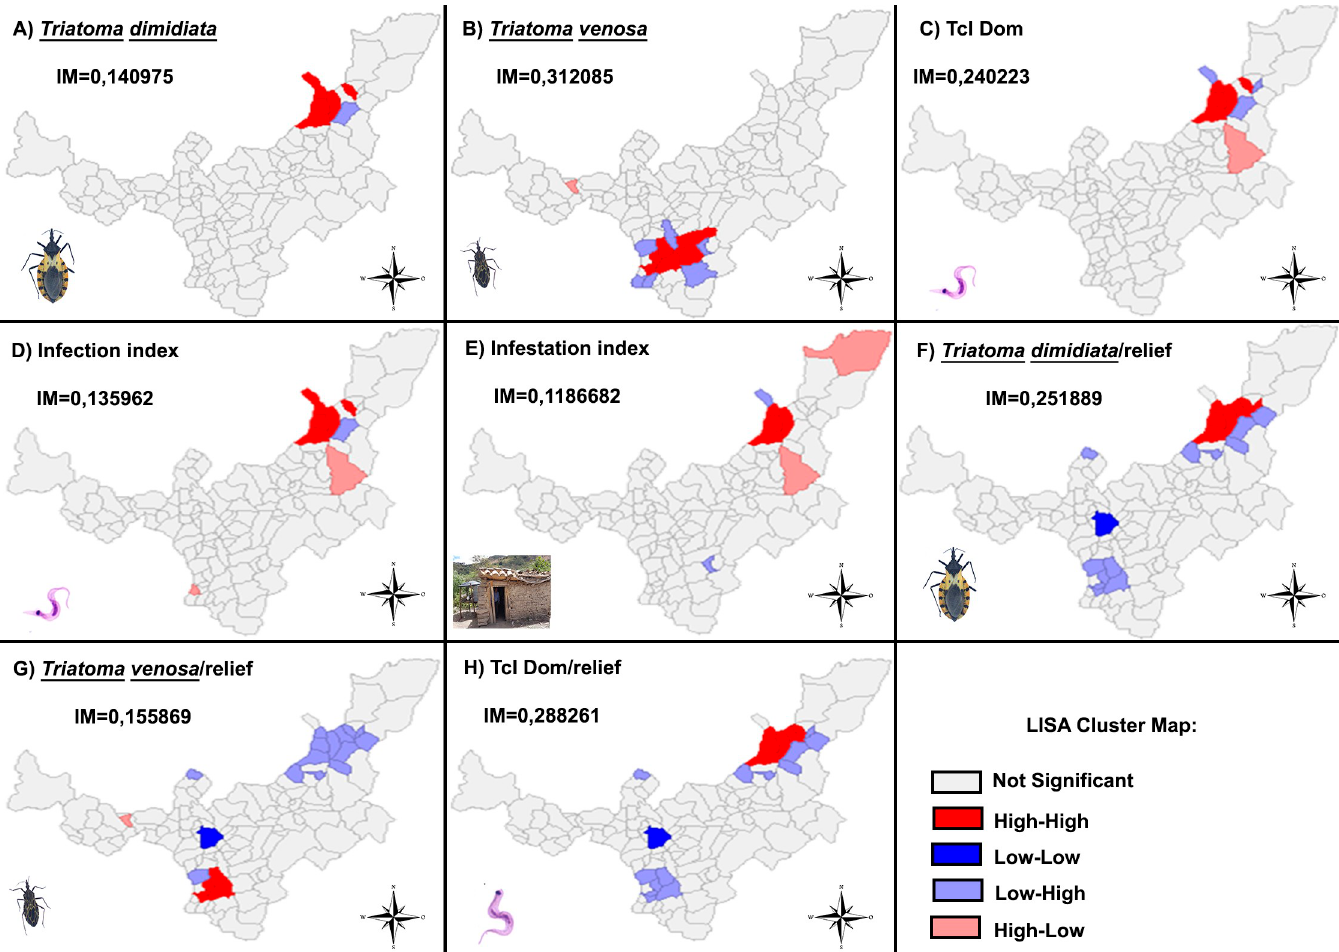
Fig 3. Maps of the index of correlation of univarite local Moran´s I in the distribution of: A. T . dimidiata , B. T . venosa , C. TcI Dom, D, Infection index, and E. Infestation index. Bivariate local Moran´s I between: F. T . dimidiata /relief, G. T . venosa / relief and H TcIDom/ relief. Boyaca department between 2017 and 2018. The map was built using the free and open source QGIS software version 3.4 (https://www.qgis.org/en/site/forusers/download.html) and shapefiles were obtained from the free and open source DIVA-GIS site